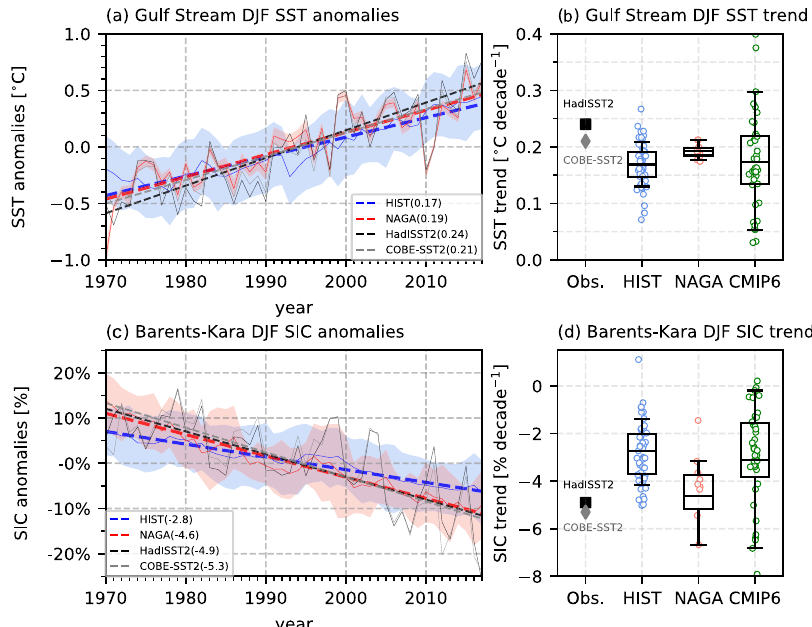
Fig. 1 Observed and simulated time series and linear trends of winter SST in the Gulf Stream and SIC in the Barents-Kara Sea for 1970 – 2017. a DJF mean SST anomalies (thin lines) and linear trends (dashed lines) averaged over the Gulf Stream region (30° – 80° W, 30° – 50° N; the region is indicated with a box in Fig. 4) based on the observation (HadISST2; black, COBE-SST2; gray) and the ensemble means of 10 members for HIST (blue) and NAGA (red). Shading indicates one standard deviation of ensemble members in both experiments. Linear trend per decade for each data set is shown in the legend. Ten members for HIST are estimated using the Monte Carlo method (Methods). b Box-whisker plots of DJF Gulf Stream SST trends for 10 equivalent members (Methods) in HIST (blue), 10 members in NAGA (red), and 39 members in CMIP6 (green). The boxes extend from the 25% to 75% values of the data, with a line at the ensemble mean. The whiskers denote the range from 5% to 95% of the data. Circles indicate all members for HIST (blue), NAGA (red), and CMIP6 (green). Black and gray markers indicate HadISST2 and COBE-SST2, respectively. c , d As in a and b , but for Barents-Kara SIC (20° – 70° E, 65° – 85° N; the region is indicated with a box in Fig. 2a,